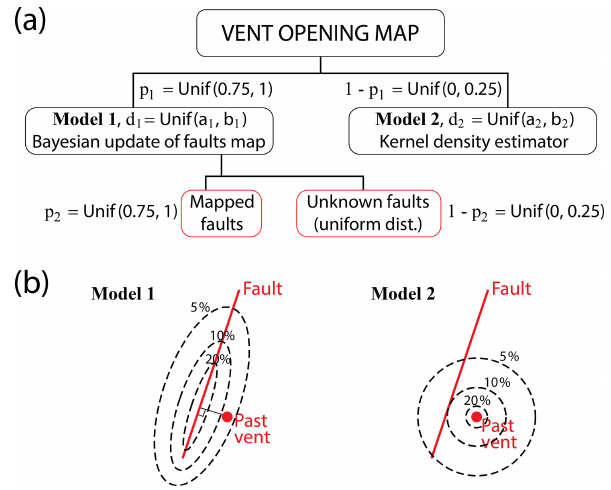
Figure 2. (a) Logic tree of the multi-model scheme presenting epis- temic uncertainty sources. Random variables modeling epistemic uncertainty sources are displayed. Red boxes show the two maps of prior probability of faults locations. (b) Schematic example of the application of the two models used in this work in the test case of a past vent near a